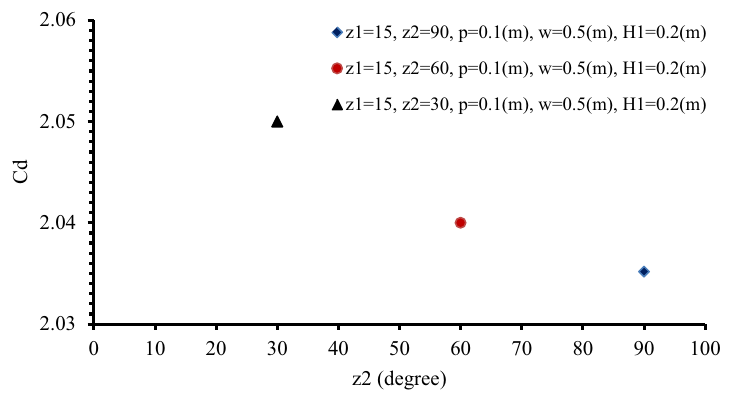
(a) Discharge coefficient and upstream face slope for similar hydraulic